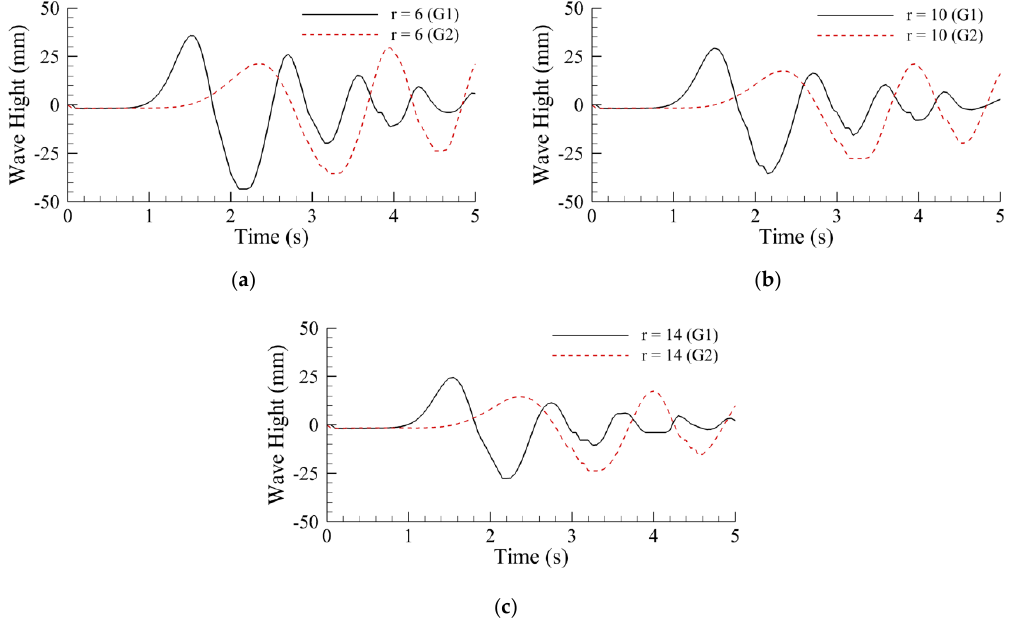
Figure 16. The temporal evolution of the water elevation in G 1 and G 2 with the subaerial landslide: ( a ) r = 6; ( b ) r = 10; and ( c ) r = 14.